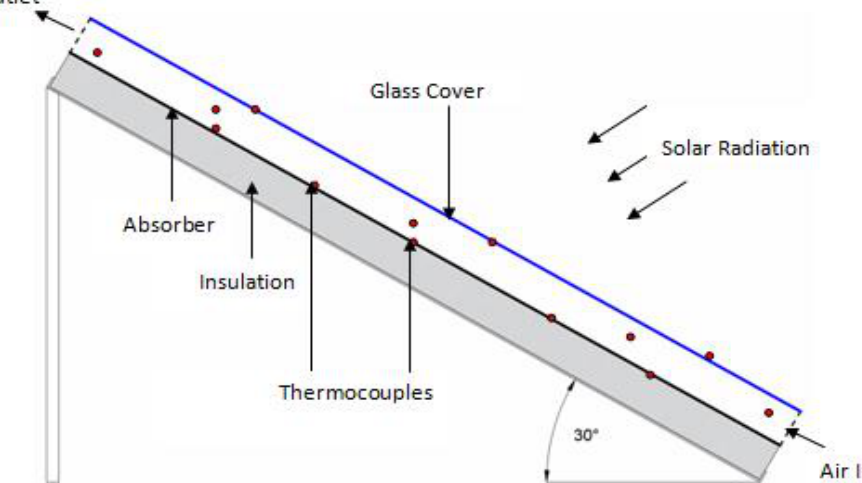
Figure 1. A schematic view of the conventional FPSAH, Case A.